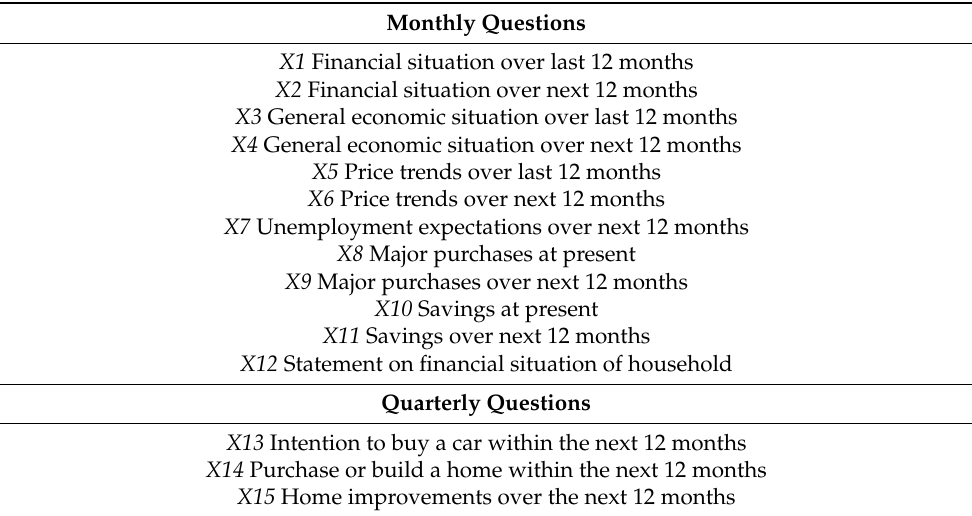
Table 2. Survey indicators—consumer